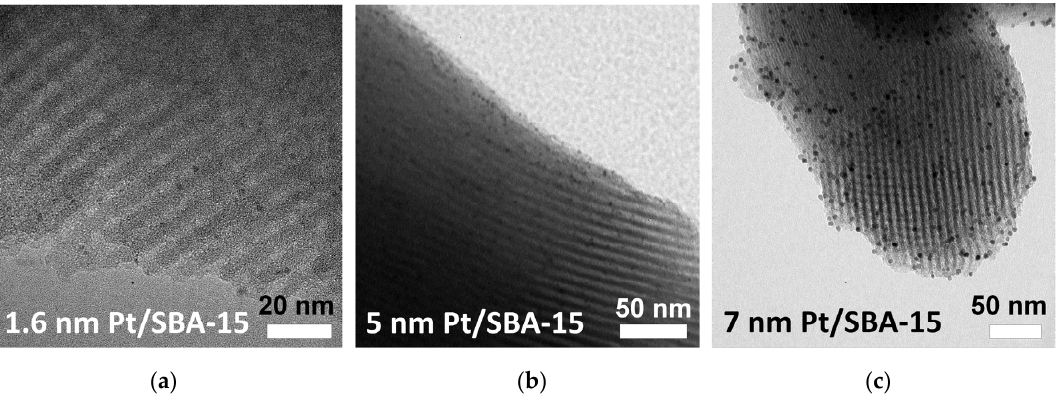
Figure 3. SBA ‐ 15 supported Pt nanoparticles with the size of ( a ) 1.6 nm; ( b ) 5.0 nm; and ( c ) 7.0 nm.